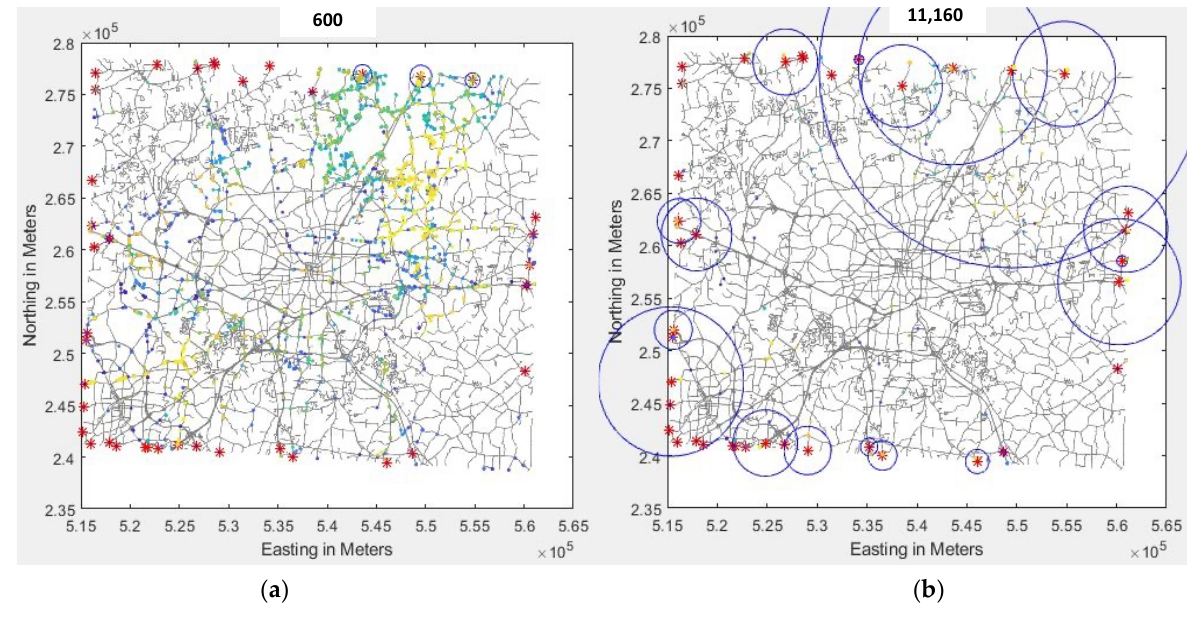
Figure 11. Evacuees moving along the roads system where ( a ) t = 600 s, and ( b ) t = 11,160 s.